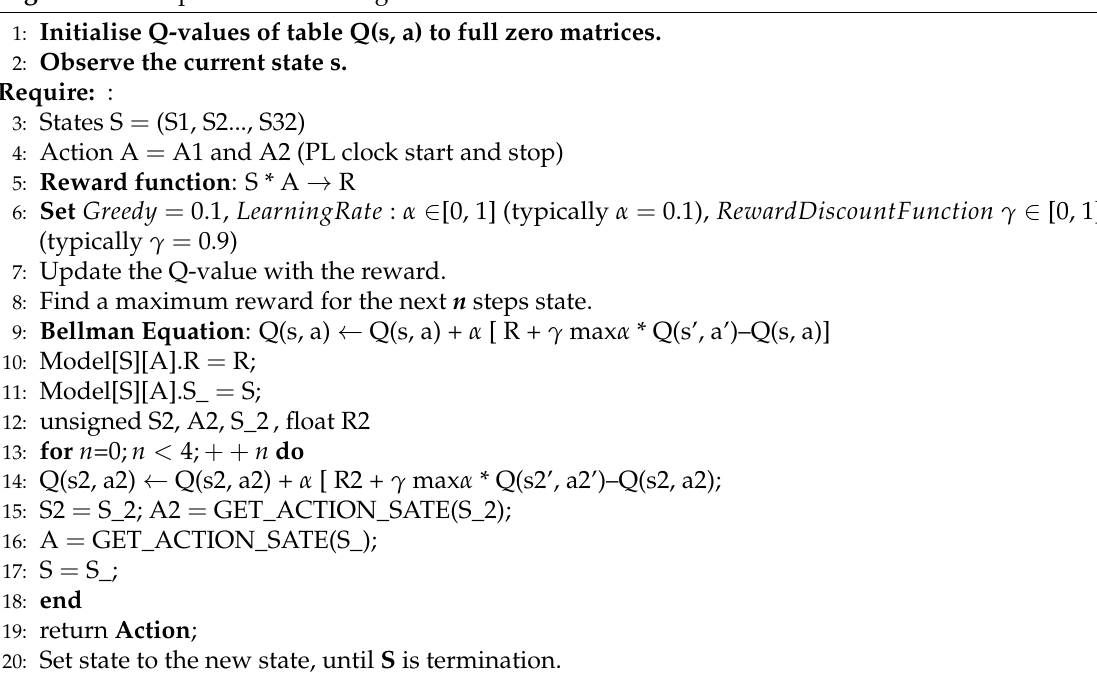
Algorithm 1 Proposed PMU-RL